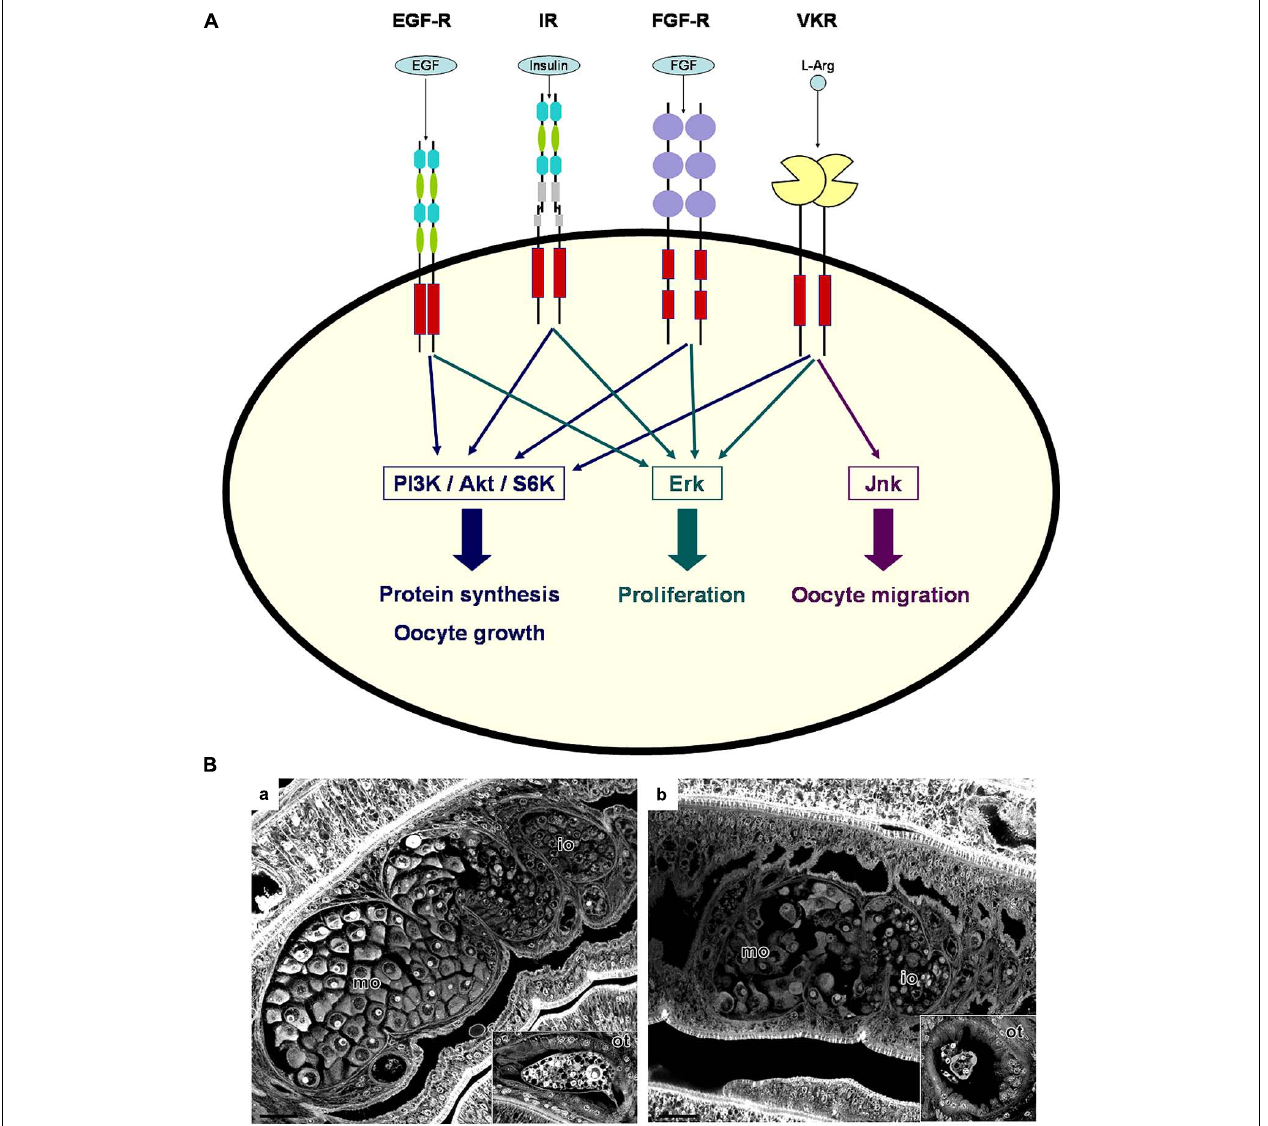
FIGURE 1 | Receptor tyrosine kinase (RTK) signaling in schistosome gonads. (A) Following activation by their respective ligands, schistosome RTKs (EGF-R, IR, FGF-R, andVKR) expressed in gonads can induce protein synthesis, cell growth and proliferation by activating the PI3K/Akt/S6K and Erk MAPK pathways.VKR activation was shown to also activate the Jnk MAPK pathway, potentially involved in oocyte migration. (B) Morphology of the reproductive organs of S. mansoni females is affected by dsSmvkr RNA interference.Worms were treated with control irrelevant (A) or dsSmvkr (B)